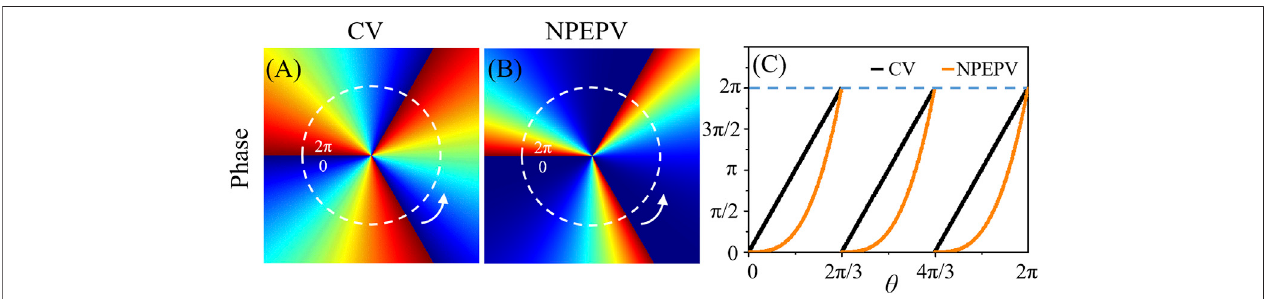
FIGURE 1 | Numerical simulation initial phases of the conventional vortex (CV) and NPEPV. (A) is the initial phase of the conventional vortex beam with TC m (cid:1) 3, andpower order n (cid:1) 1, (B) istheinitialphaseoftheNPEPVbeamwithTC m (cid:1) 3andpowerorder n (cid:1) 3,and (C) istherelationshipbetweentheinitialphasesandazimuth in a closed path marked by the white circular dashed line in Figure 1A ; Figure 1B